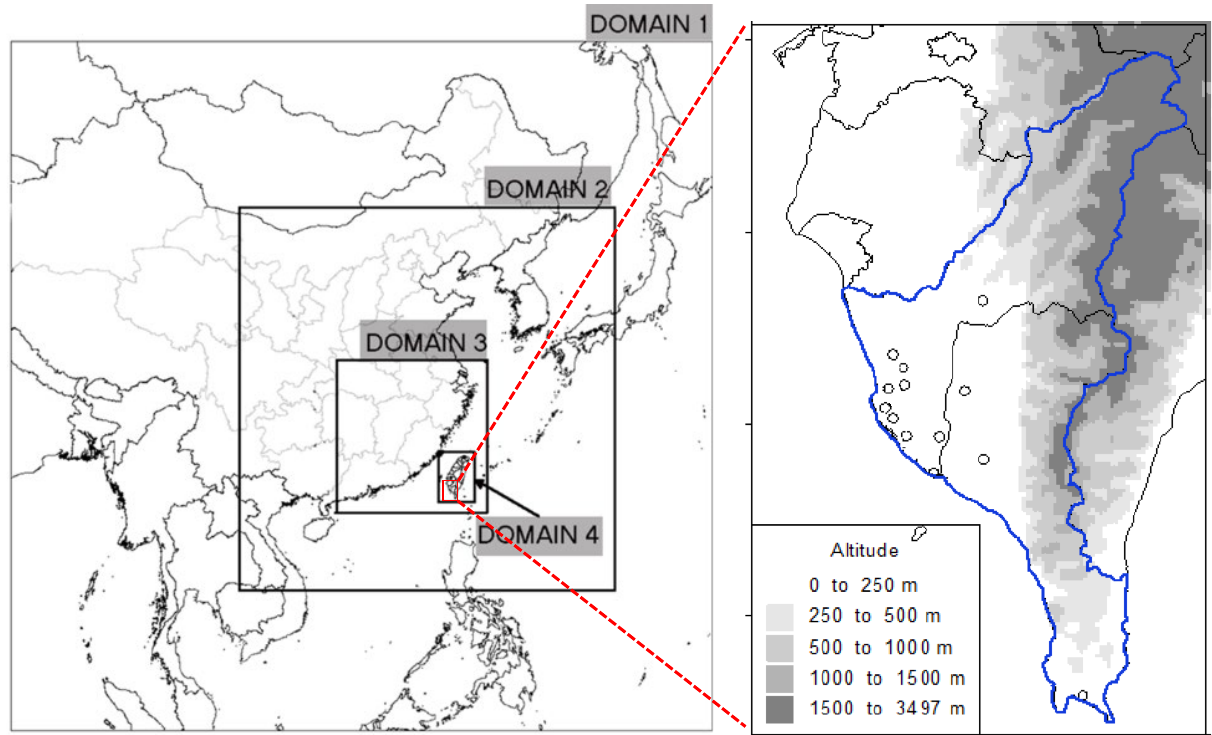
Figure 1. Configuration of four-level nesting domains (left picture), KPAB district (area surrounded by blue frame in right picture), and air quality monitoring locations within KPAB (circles in right picture ).